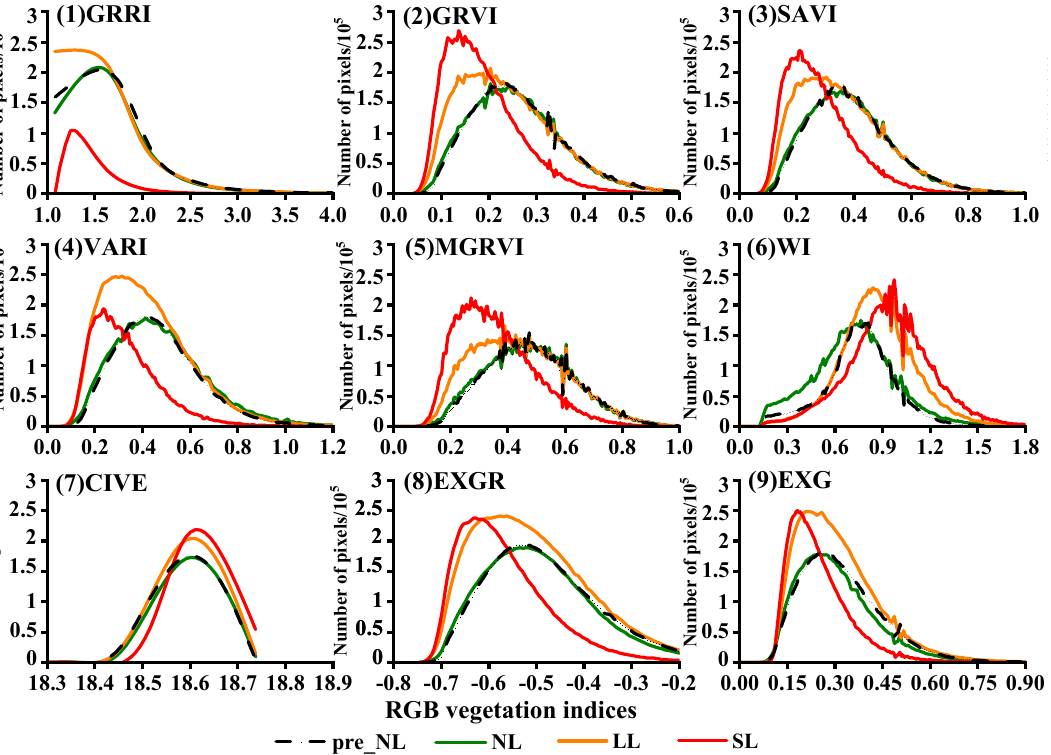
Figure 11. Histograms of nine vegetation indices for different degrees of lodging. The green solid curve corresponds to the NL plot after lodging and is basically consistent with the histogram of the plot before lodging (gray dotted curve). The yellow curve corresponds to LL and red to SL land. With increasing degree of lodging, some vegetation indexes peak at higher values, whereas others peak at lower values.